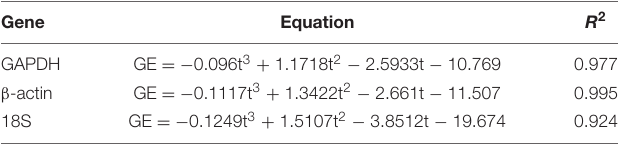
GE and t indicate the relative expression and decomposition